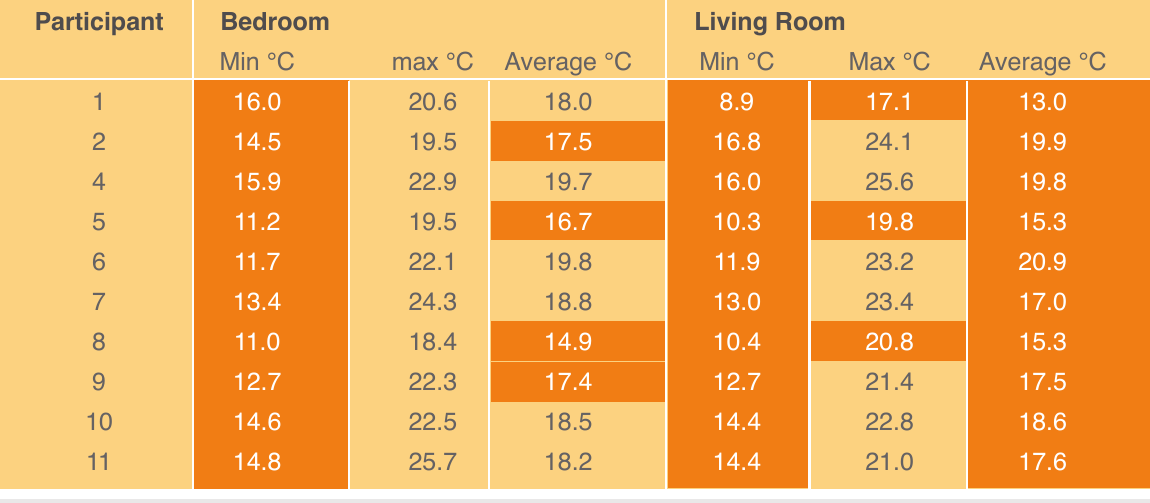
Table 3 Minimum, maximum and average temperature